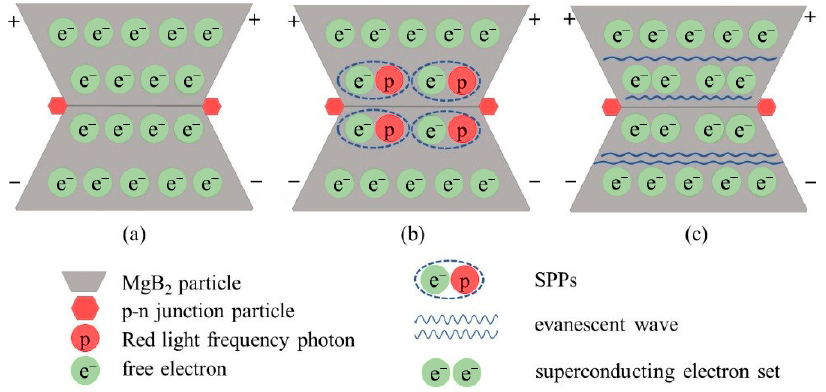
Figure 9. Schematic diagram of smart superconductivity generation. ( a ) Free electrons are uniformly distributed in the superconductor before the measurement field is applied. ( b ) After the measurement electric field is applied, the p-n junction particles in red light wavelength glow and generate a large number of photons. The interaction between photons and some conduction electrons occurs at the particle interface, forming plasmons. ( c ) These surface plasmons propagate as evanescent waves and can transport superconducting electrons. Due to the unimpeded transmission of evanescent wave, the superconductivity of system electrons at higher temperature is pro- moted.